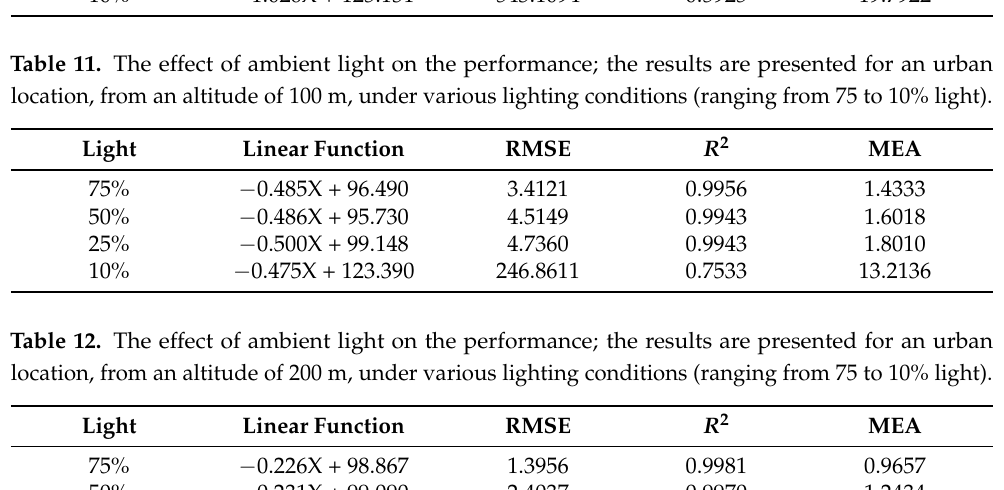
Table 10. The effect of ambient light on the performance; the results are presented for an urban location, from an altitude of 50 m, under various lighting conditions (ranging from 75 to 10% light). Light Linear Function RMSE R 2 MEA 75% − 1.063X + 99.575 3.0514 0.9967 1.4503